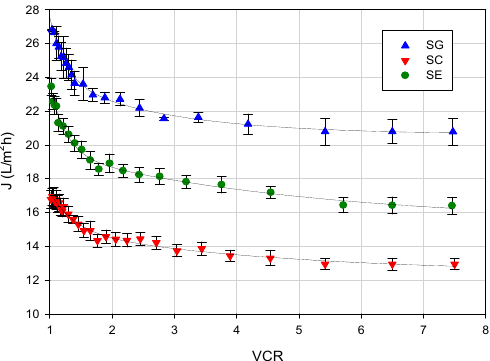
Figure 5. RO of evaporator condensate stream. E ff ect of volume concentration ratio (VCR) on the permeate flux (operating conditions: temperature, 20 ± 1 ◦ C; feed flowrate, 360 L / h; TMP, 25 bar).